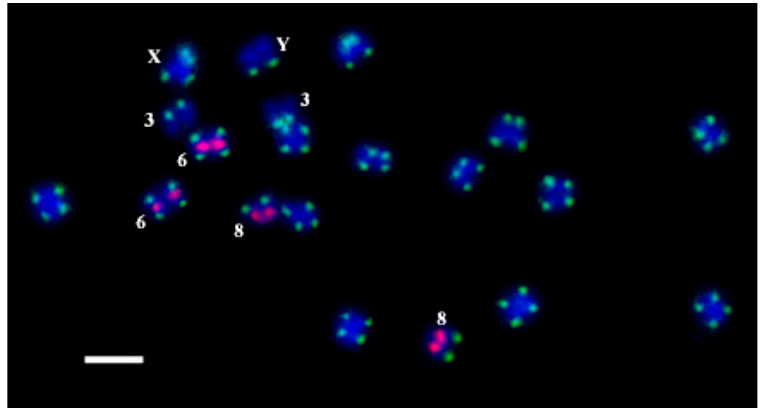
Figure 2. The results of oligo-FISH experiments with the oligo-probes CS-1-FAM (green) and CS-237-TAMRA (pink) on C. sativa chromosomes. Distinguished chromosomes are indicated according to Alexandrov et al. [31]. Bar equals 5 μ m.